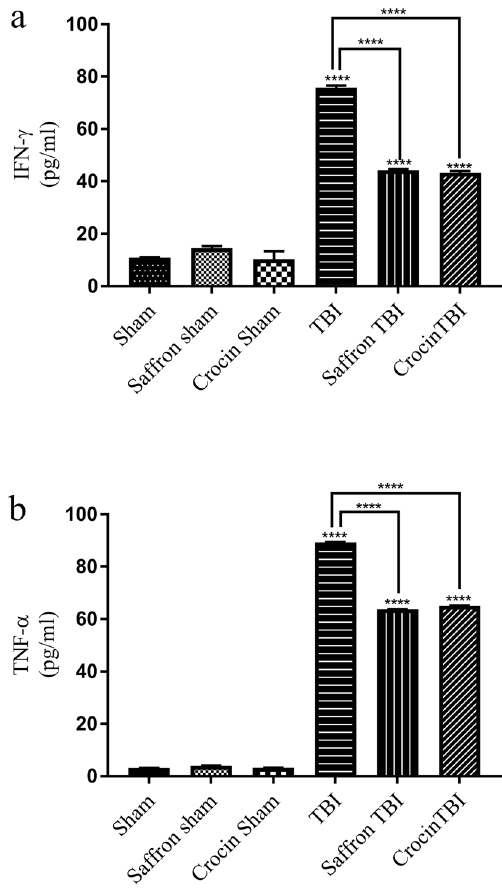
Figure 6. Effect of saffron extract and crocin on IFN-γ and TNF-α Levels in cortex homogenates. ( a ) IFN-γ levels in all groups. ( b ) The concentrations of TNF-α. Data are represented as means of three determinations ± SEM. (****) corresponds to p-value <